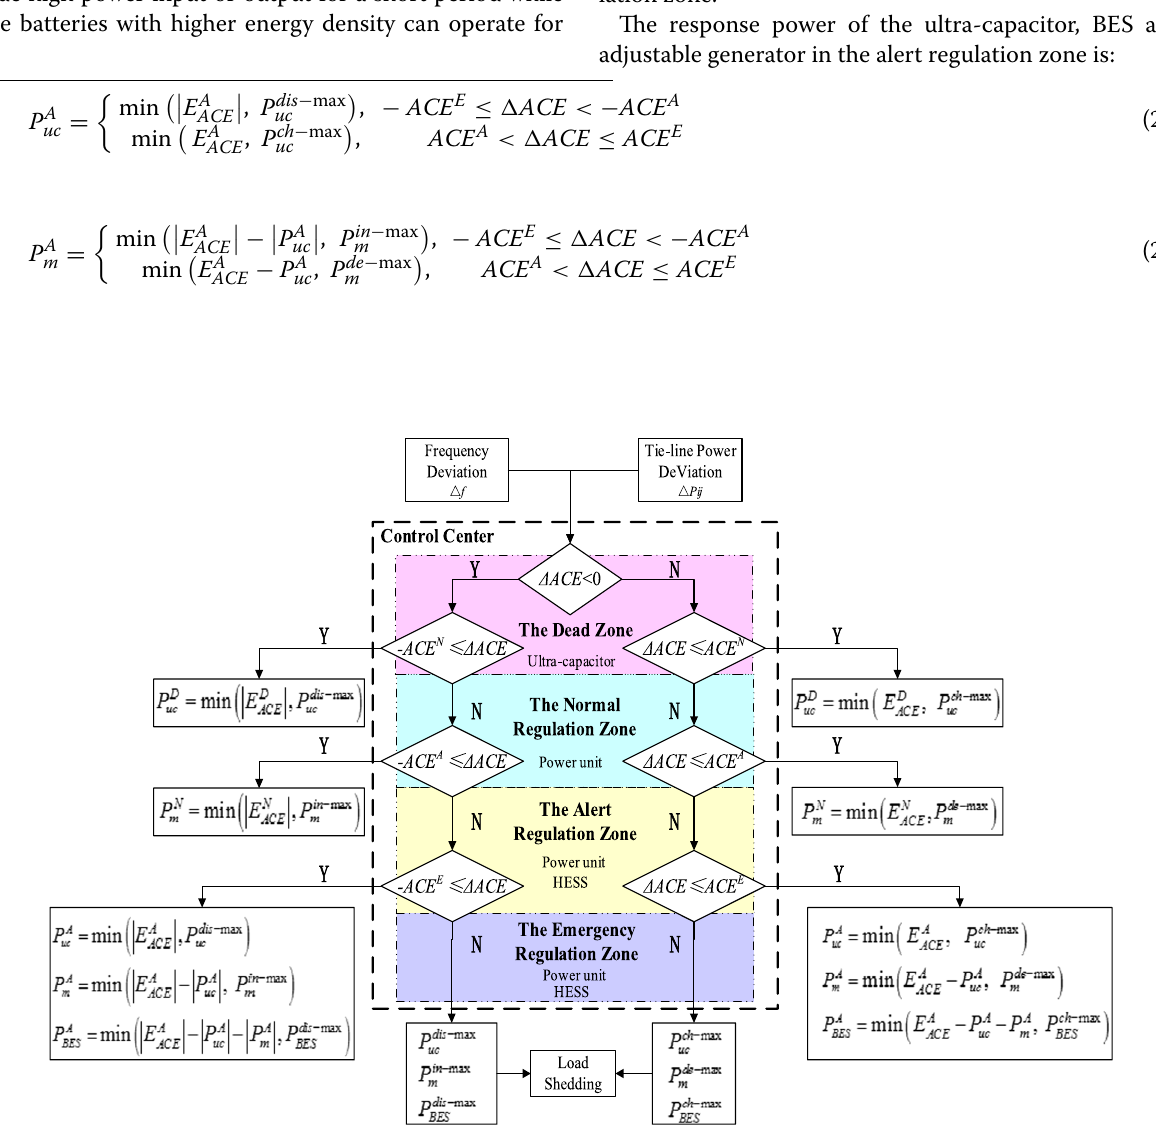
Fig. 5 The diagram of coordinated control